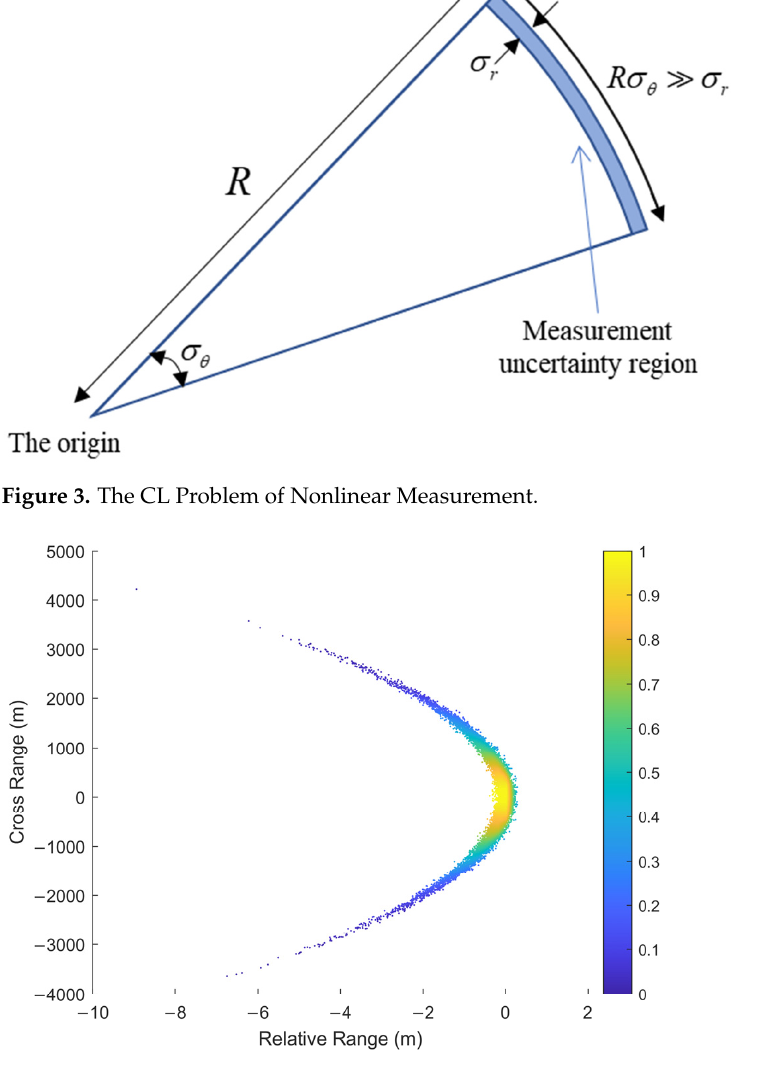
Figure 4. The non-Gaussian CL error distribution.